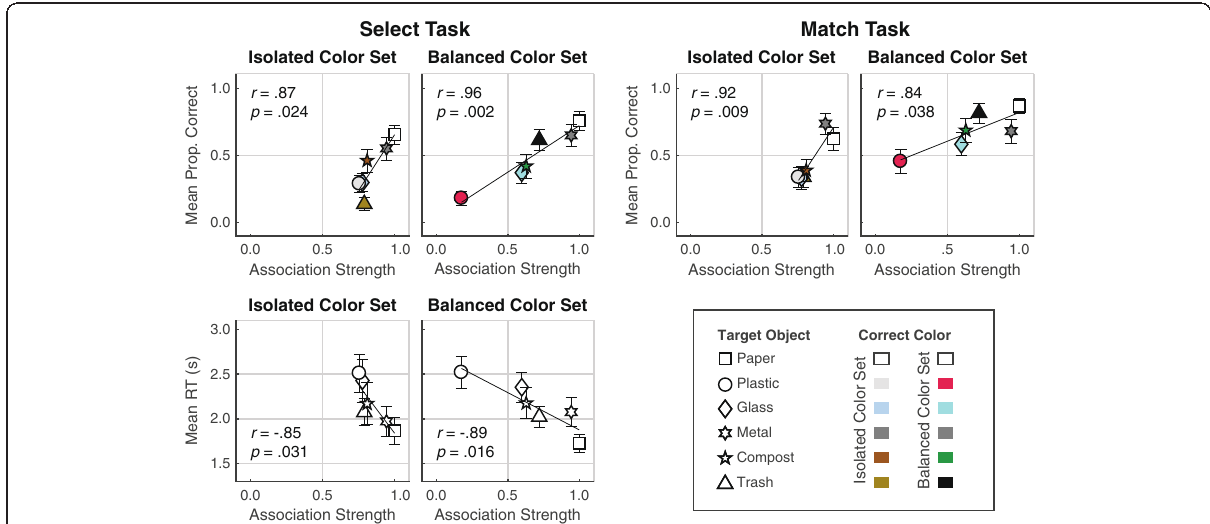
Fig. 12 Mean proportion of correct responses as a function of color-object association strength (association ratings from Fig. 4) between objects and the correct color for each color set in the select and match tasks ( top row ). The color of the points represents the color of the correct response. Mean RTs as a function of color-object association strength between objects and the correct color for each color set in the select task ( bottom left ). There is no corresponding RT figure for the match task because there were not separate RTs for objects in the match task. The points are unfilled to in- dicate that these were mean RTs for all trials, regardless of whether responses were accurate. Error bars represent±standard errors of the